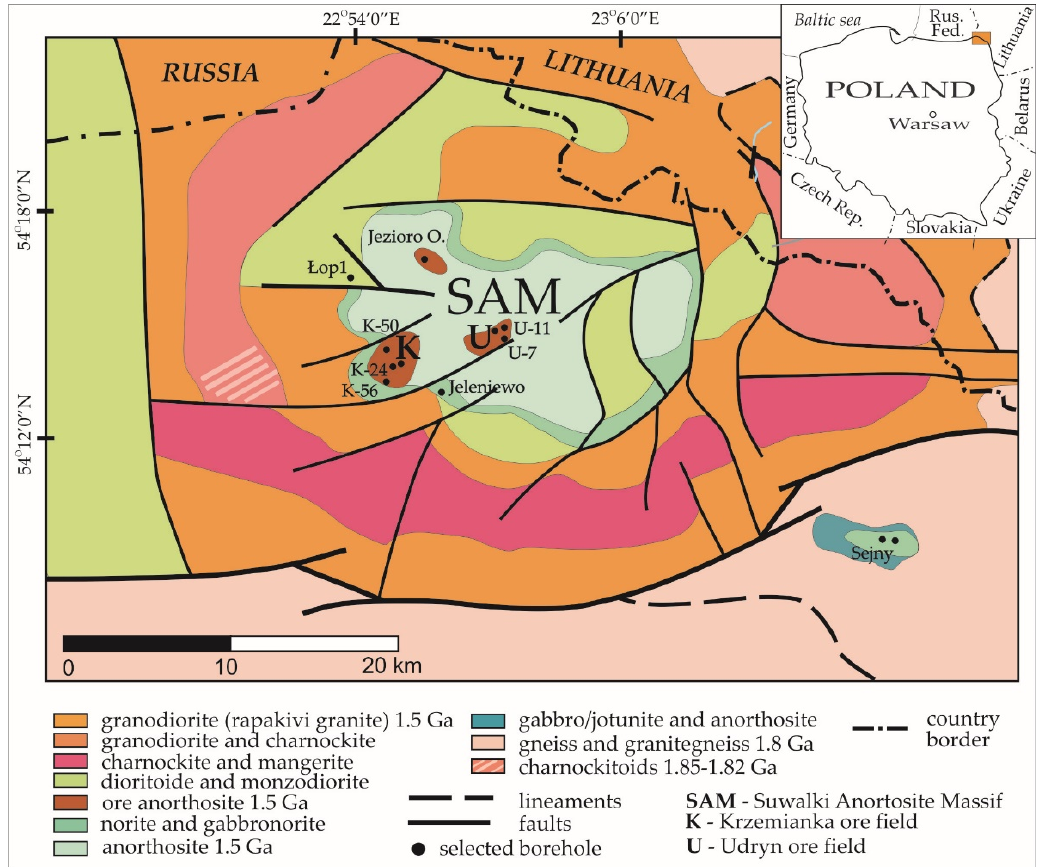
Figure 1. Schematic geological map (without Palaeozoic–Cenozoic sedimentary rock cover) of the Suwałki Anorthosite Massif (modified after [9]) with the location of the Krzemianka and Udryn Fe-Ti-V deposits in NE Poland.